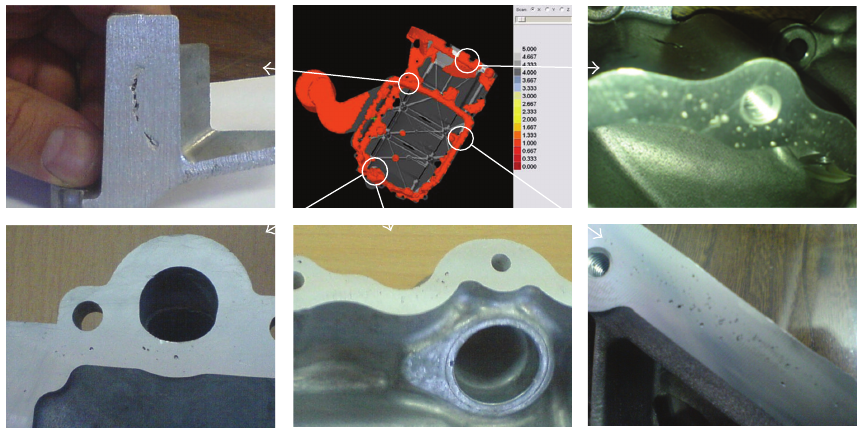
Figure 12: Defects occurred in final solidification